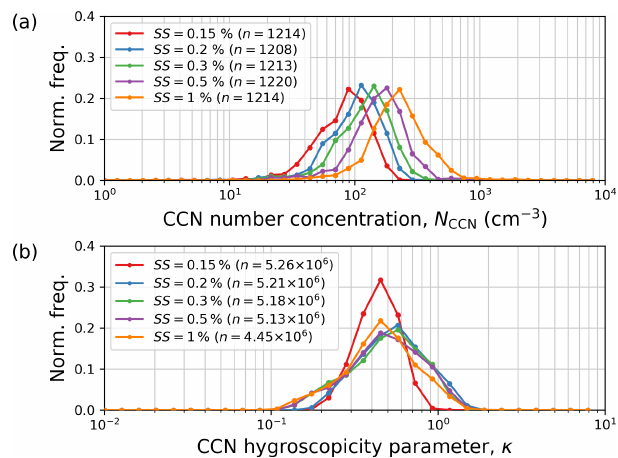
Figure 4. Normalized probability density function of (a) CCN number concentration ( N CCN ) and (b) hygroscopicity parameter ( κ ) for levels of supersaturation 0 . 15%, 0 . 2%, 0 . 3%, 0 . 5%, and 1% (SS, colour-coded) of all observations taken during Legs 1–3. The N CCN result from averaging 5min long intervals of 1Hz mea- surements. Each of the six SS levels is repeated once per hour. The κ values result from Monte Carlo simulation runs ( n MCS = 10 4 ) of hourly smoothed particle number size distributions. All κ values that resulted from D crit outside of 10th to 90th percentile range (per SS) are excluded. The number of data points are indicated ( n ) in the